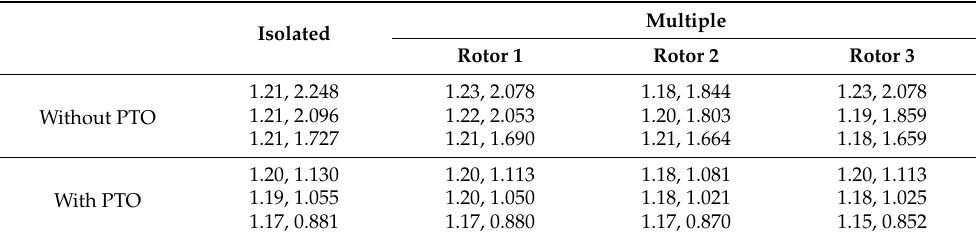
Table 2. Peak pitch RAO (rad/m) of isolated and multiple WEC rotors with and without the PTO damping for different wave-heading angles ( ◦